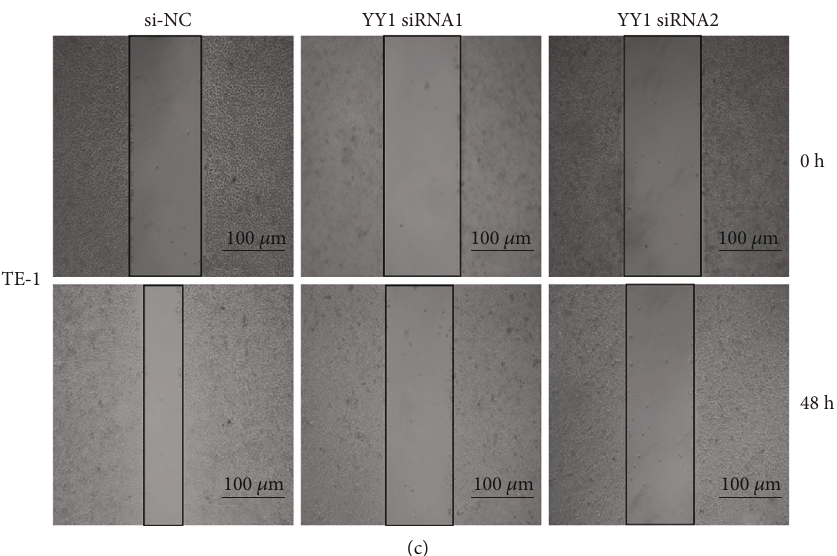
Figure 7: Silencing YY1 inhibited proliferation and migration of of ECA109 and TE-1 cells. (a) Determination of proliferation ability of ECA109 and TE-1 cells by clone formation. (b, c) Determination of the migratory ability of ECA109 and TE-1 cells by wound-healing assay. Scale bar = 100 μ